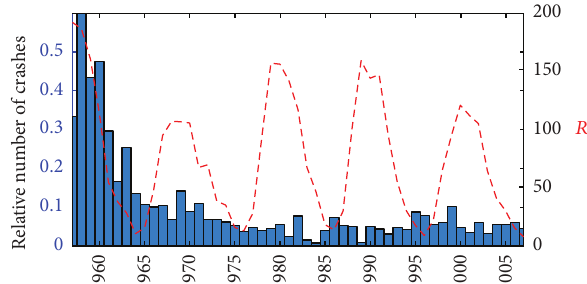
Figure 8: The comparison of yearly distributions solar activity, as characterized by sunspot number ⟨𝑅⟩ (red curve) and the relative number of crashes for all launches from 1957 till 1975 (blue